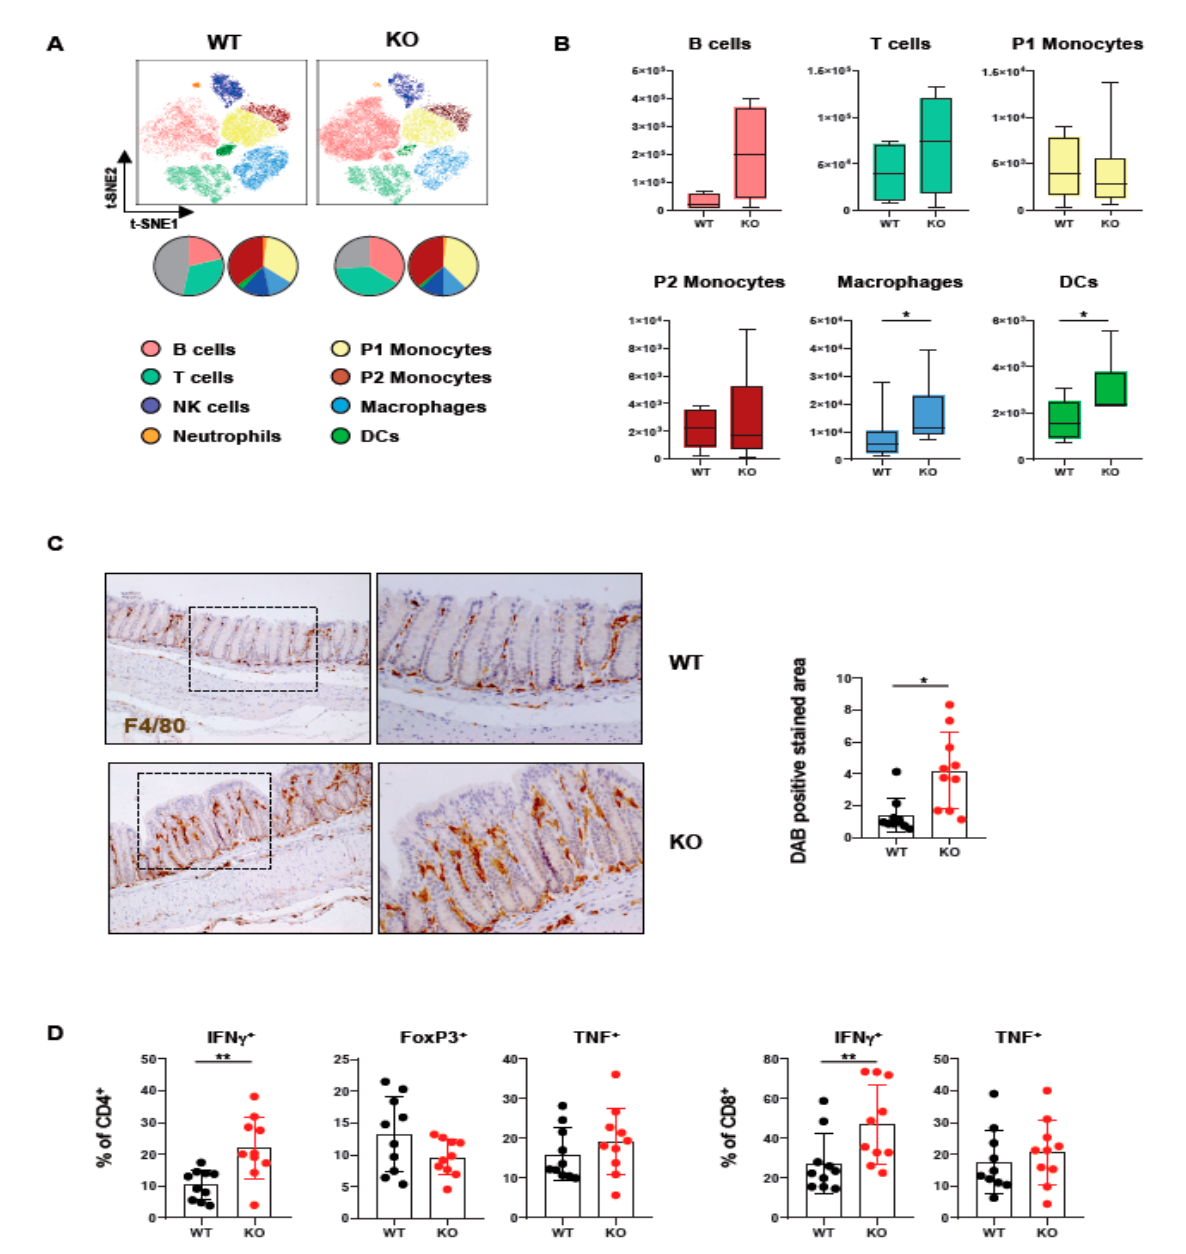
Figure 1. Loss of PTPN2 in DCs affects immune cell populations in the lamina propria. Immune cells were analyzed in PTPN2 fl/fl (WT) and PTPN2 fl/fl xCD11c Cre (KO) mice: ( A , B ) t-SNE maps displaying live, CD45 + singlet cells in lamina propria lymphocytes (LPL). Colors correspond to FlowSOM-guided clustering of cell populations. Pie charts represent relative numbers among CD45 + cells; ( A ) t-SNE maps of CD45 + cells in LPL; ( B ) total counts of indicated cell populations in LPL; ( C ) IHC staining for F4/80 + macrophages in colon; ( D ) relative numbers of Tregs, IFN γ - or TNF-producing CD4 + and CD8 + T cells. * p < 0.05, ** p < 0.01; unpaired Mann–Whitney test, n = 5–7 per group.